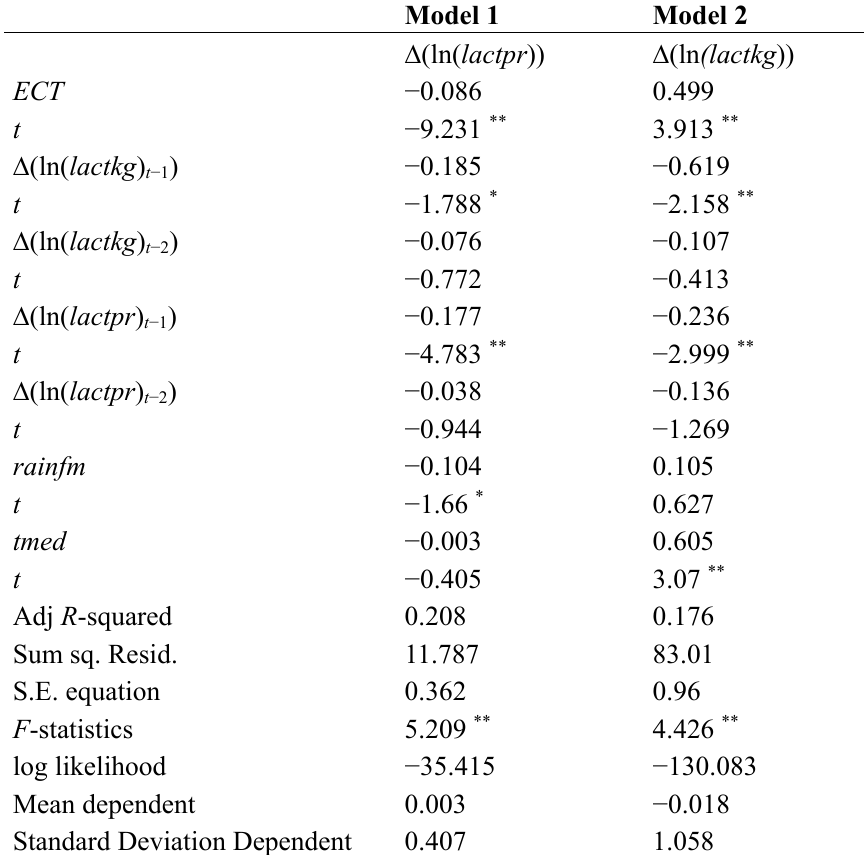
Table 6. Vector error correction